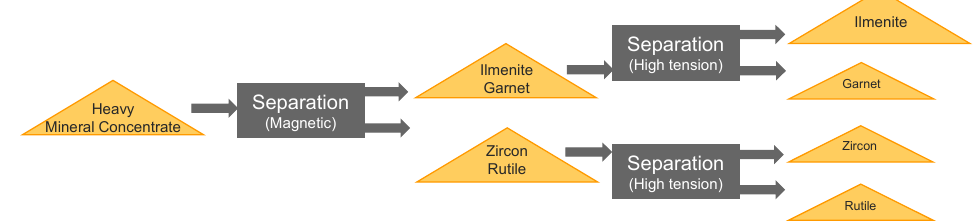
Figure 4. Simplified flow sheet of heavy mineral separation.